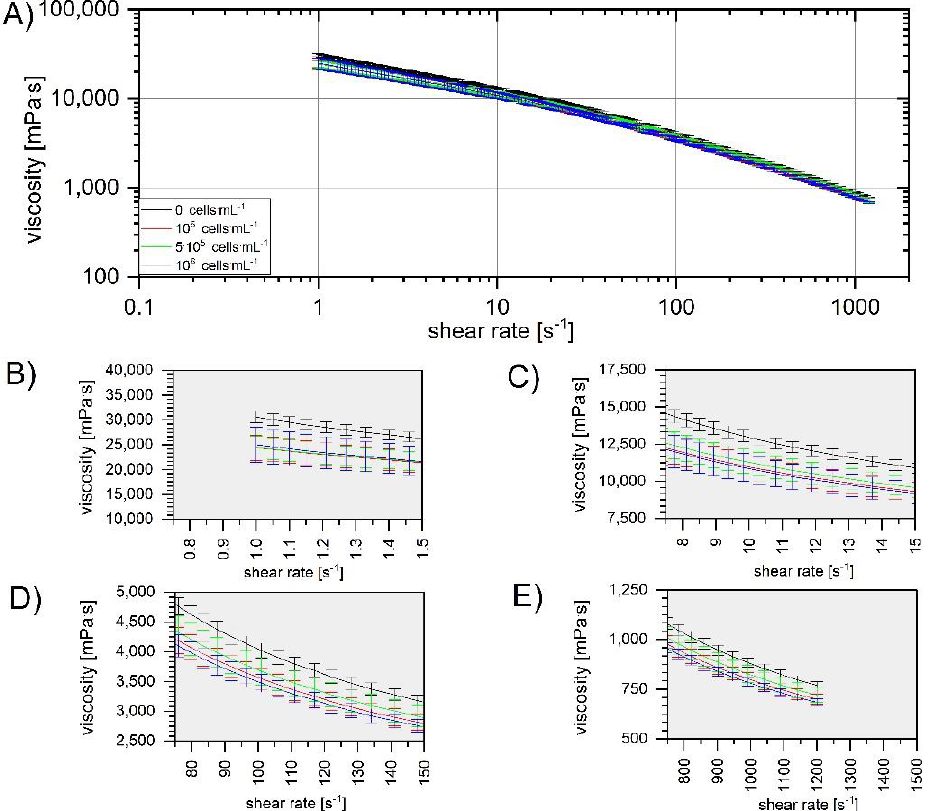
Figure 6. The effect of shear on the properties of the cell-free carrier and cell-laden bioink. ( A ) The overall flow curve. ( B – E ) Zoomed segments of the flow curve showing shear characteristics in the low, medium, and high shear regions. The carrier material (no cells) is shown in black, whereas the bioinks are shown in red (10 5 cells·mL −1 ), green (5·10 5 cells·mL − 1 ), and blue (10 6 cells·mL −1 ). Data are means ± SD ( n = 3).